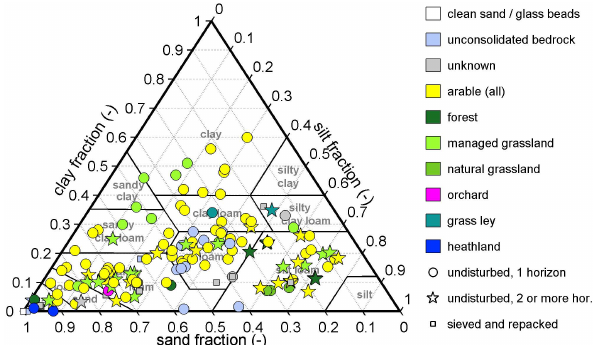
Fig. 2. Land uses corresponding to the soil samples on which the 733 considered BTC experiment had been carried out. Note that in most publications only average values are published for several soil samples and that several experiments are often conducted on one and the same soil sample under different hydraulic boundary conditions. Therefore, the number of datasets visible in the texture triangle is less than 733.